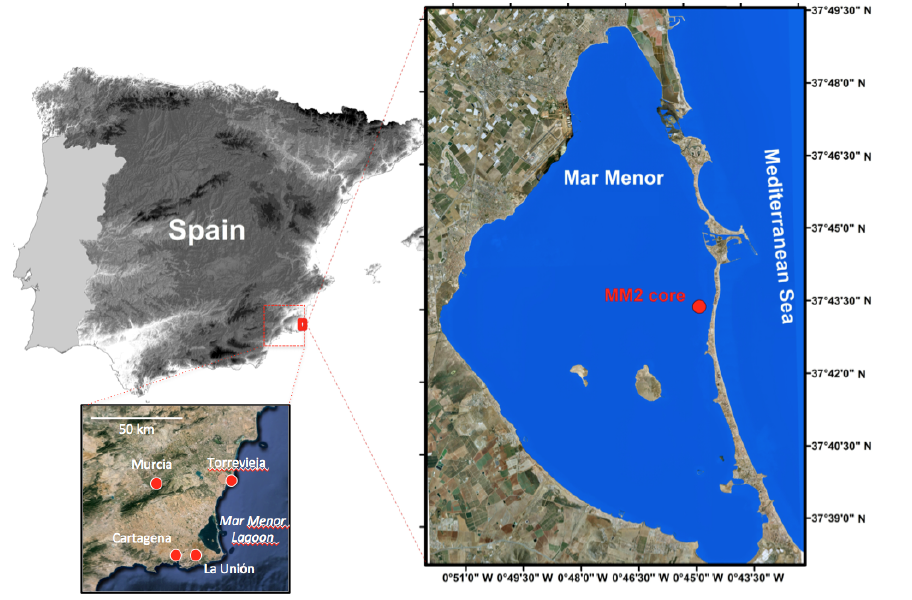
Figure 1. Map of the Mar Menor with localization of the core